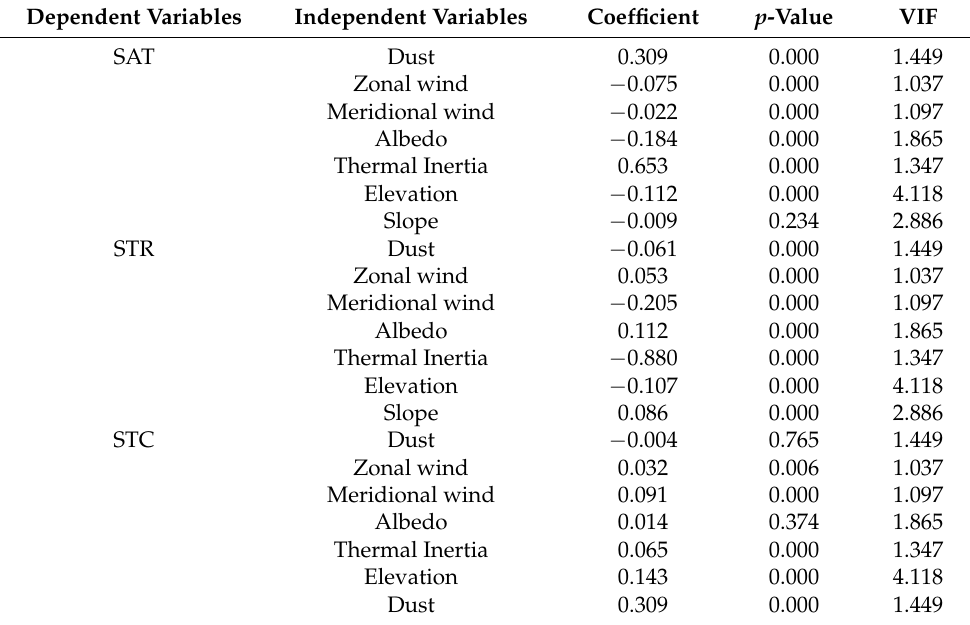
Table 1. Stepwise regression multicollinearity test results.